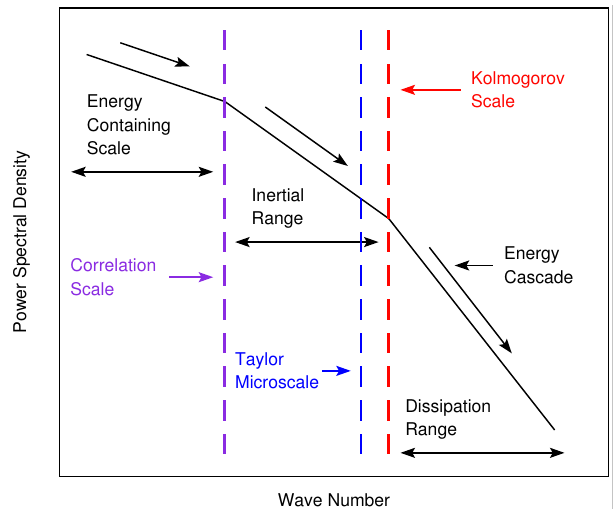
Fig. 1. Generic picture of turbulence in the solar wind showing the primary turbulence ranges and scale lengths.